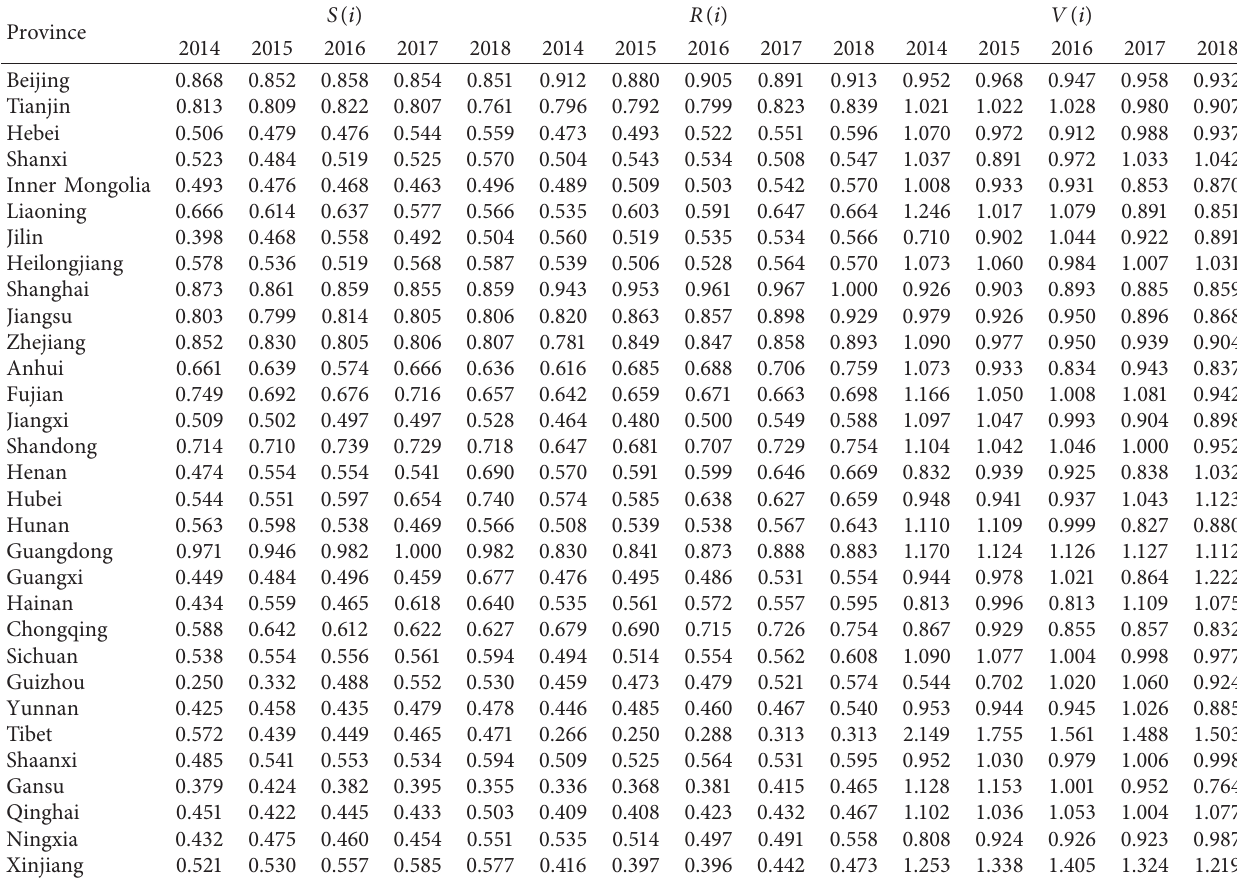
Table 1: The changing of the sensitivity index, respondence index, and vulnerability index of the tourism economy from 2014 to 2018 in provinces.